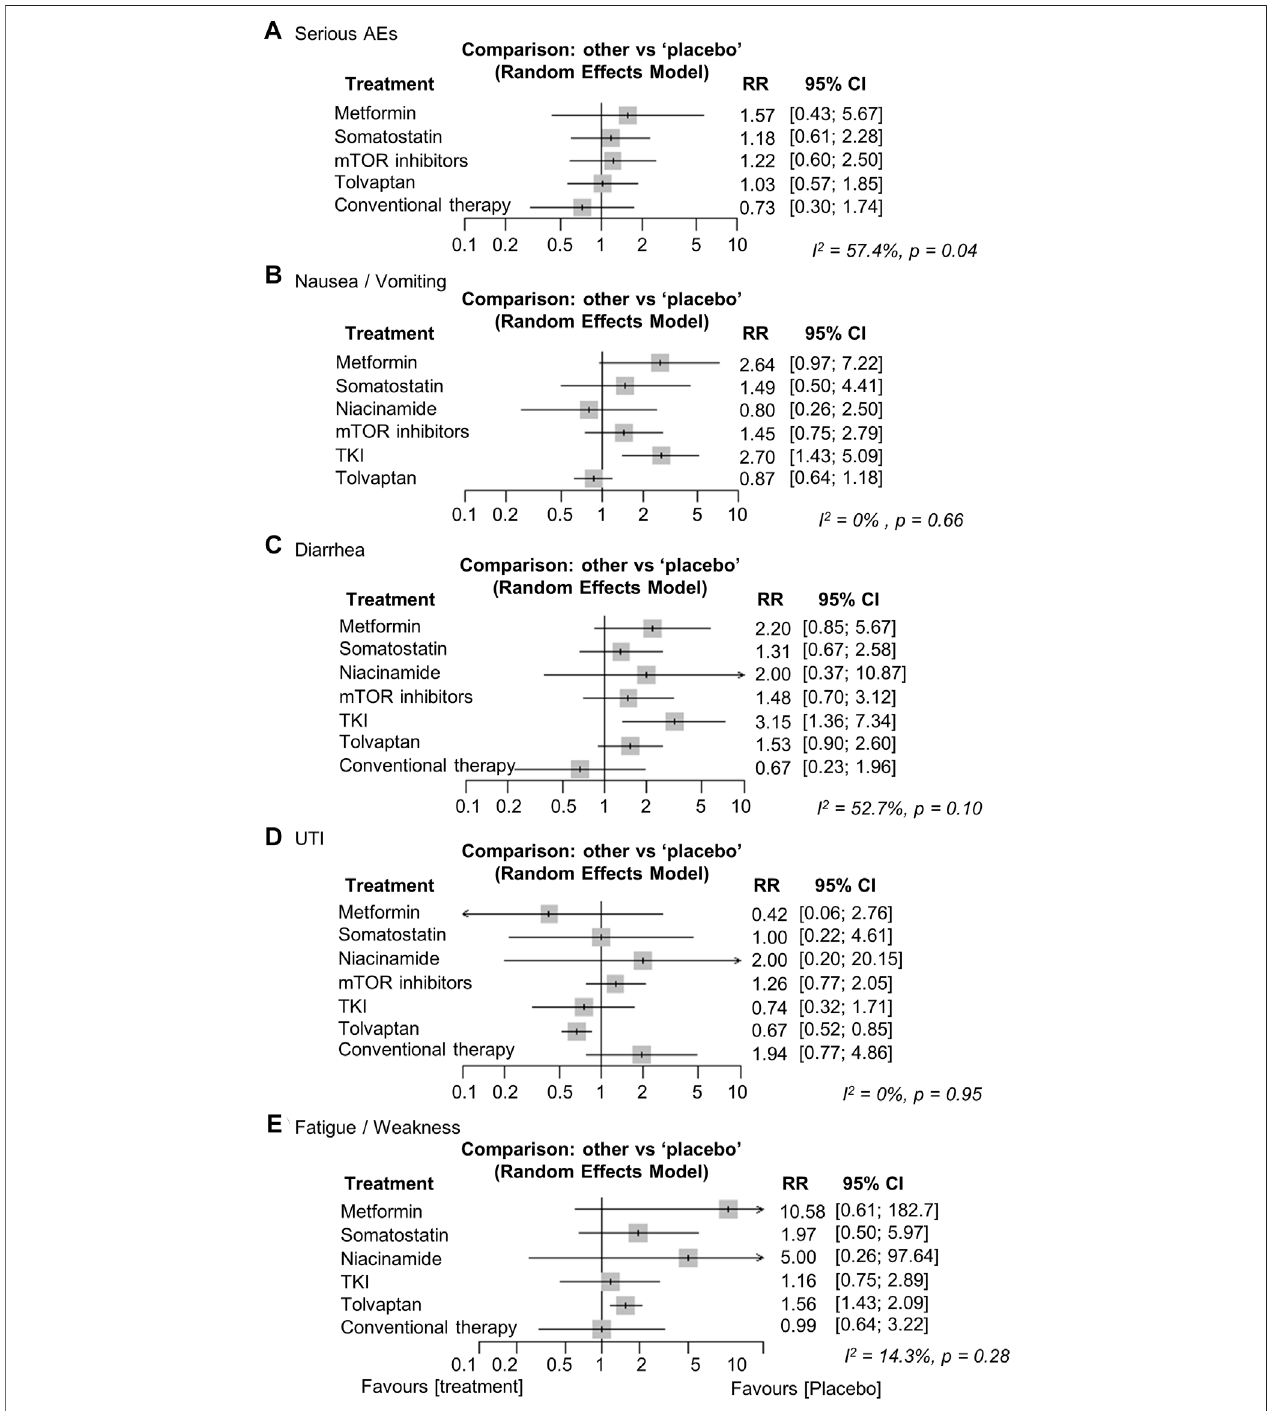
FIGURE4| Networkmeta-analysis reportingtheriskratios (RRs)for adverse events(AEs) regarding (A) seriousAEs, (B) nausea/vomiting, (C) diarrhea, (D) urinary tract infection (UTI), and (E) fatigue/weakness in ADPKD patients. CI, con fi dence interval; TKI, tyrosine kinase inhibitor; ADPKD, autosomal dominant polycystic kidney